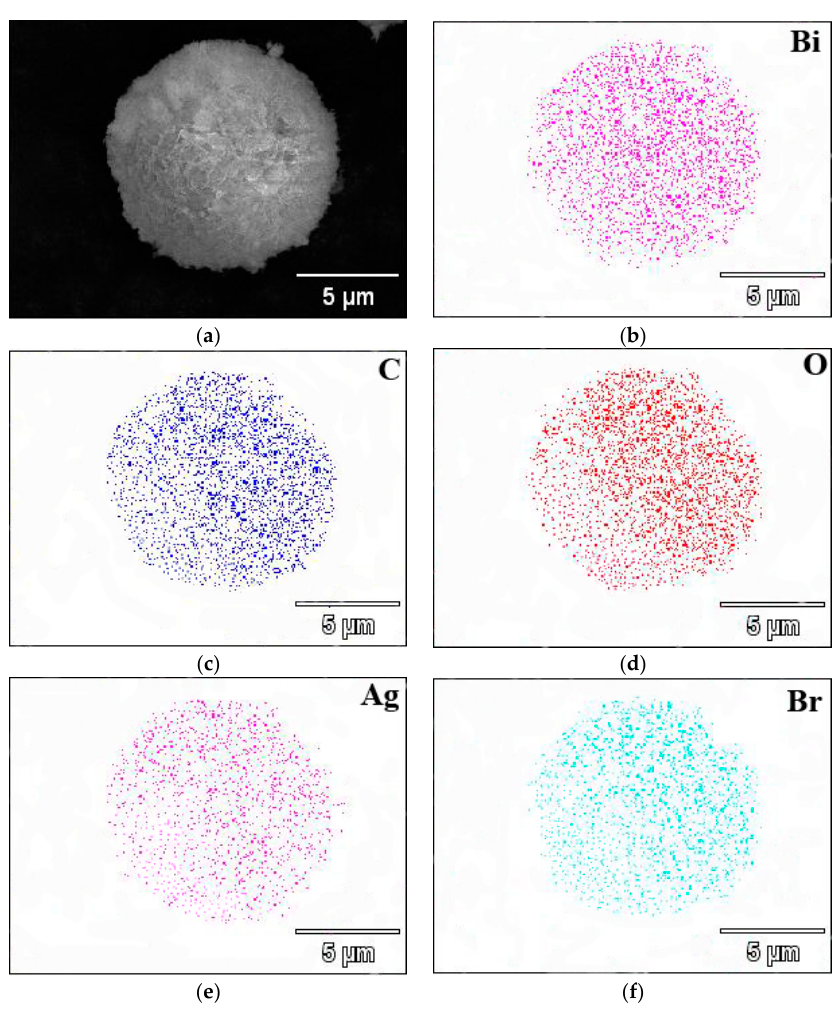
Figure 3. SEM image ( a ) and the corresponding elemental mapping images ( b – f ) of Ag@AgBr(7 wt %)/Bi 2 O 2 CO 3